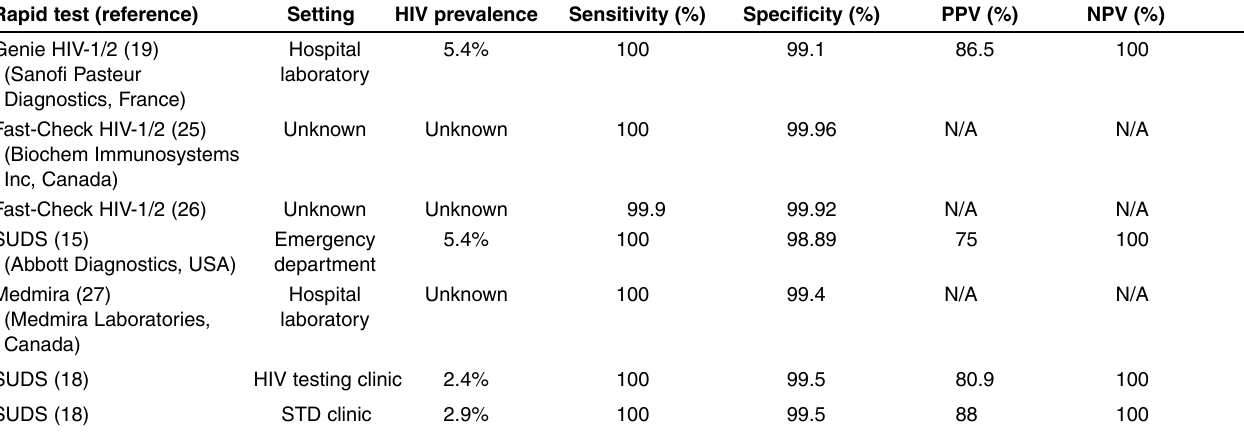
TABLE 1 Performance characteristics of point-of-care HIV test kits Rapid test